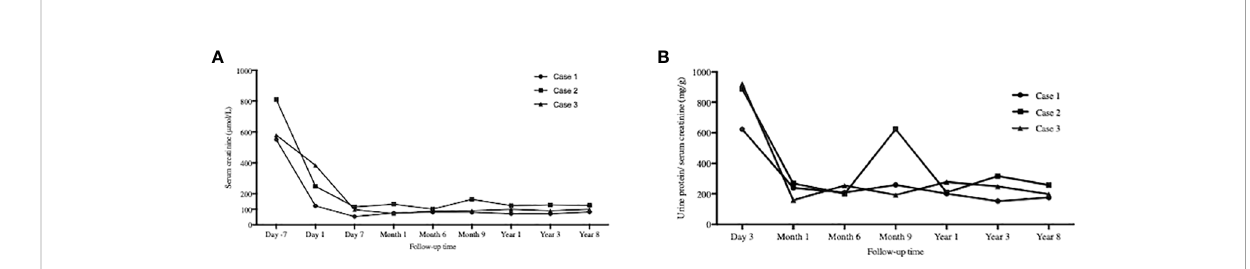
FIGURE 2 Graft function monitoring. The serial time points were 7days before KTx, day 1, day 7 and 1, 6, 9, 12, 36, 96 months after KTx for (A) Serum creatine mornitoring and day 3 and 1, 6. 9, 12, 36, 96 months after KTx for (B) Urine protein/serum creatinine. The graft function of Case 1 and